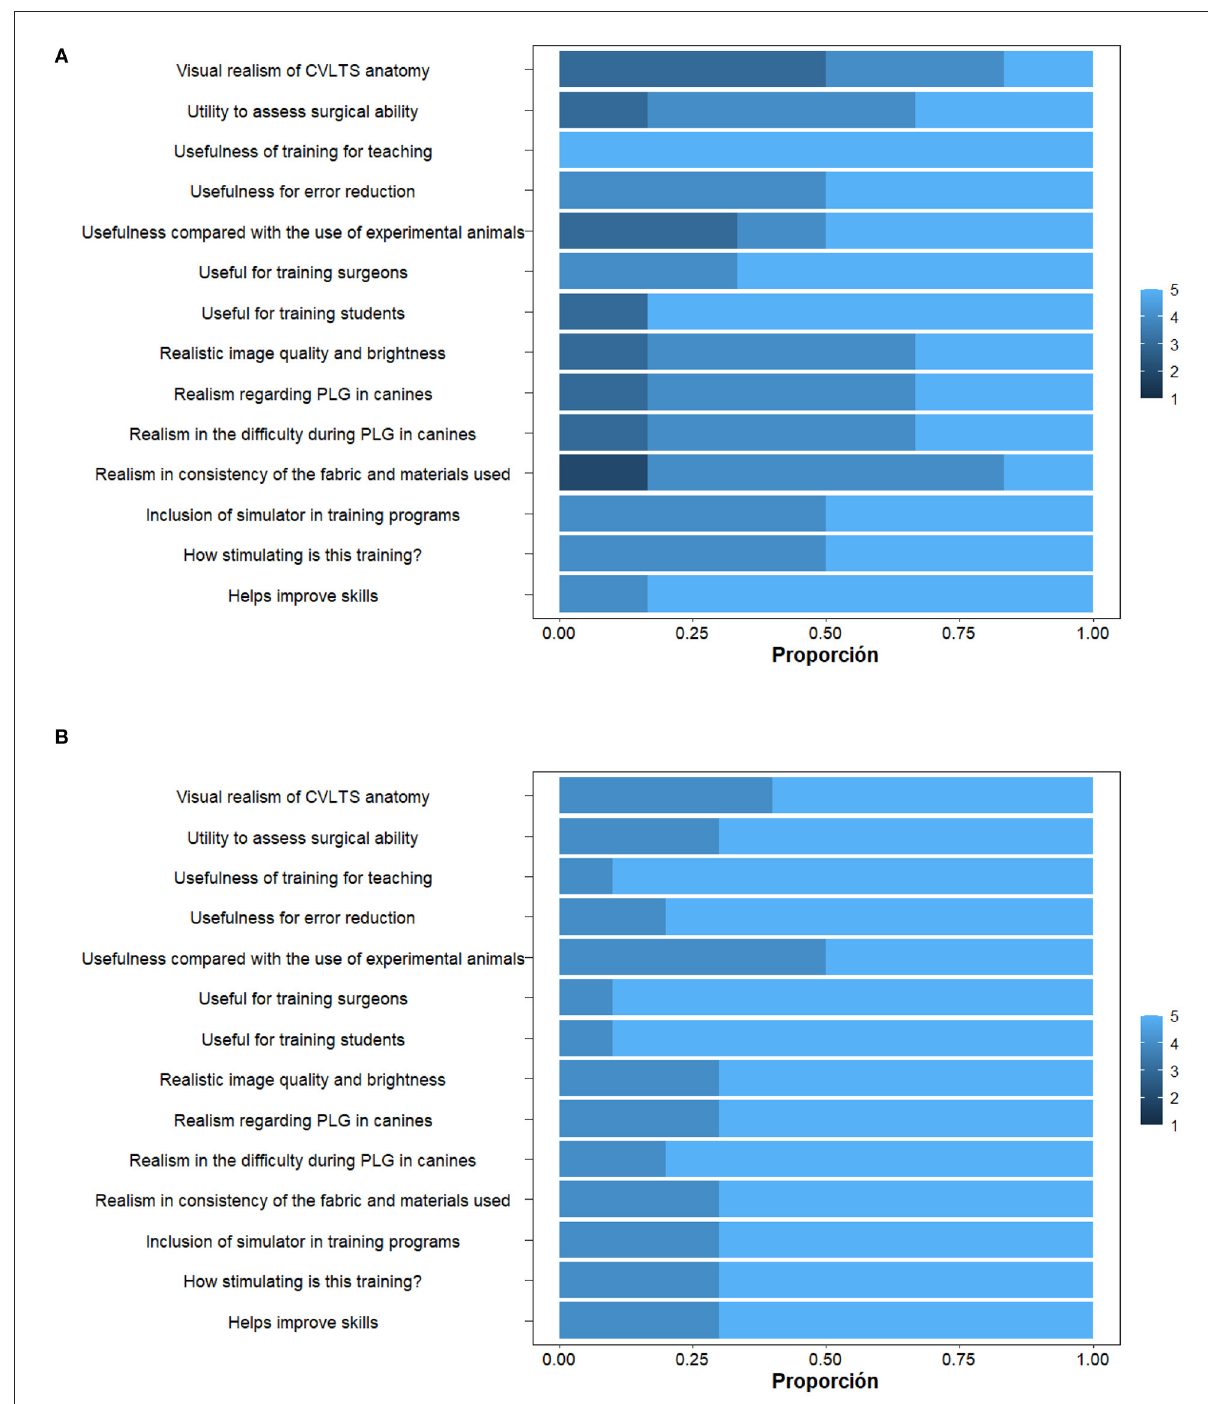
FIGURE3 Response distribution graphs between groups. (A) Group A. (B) Group B.